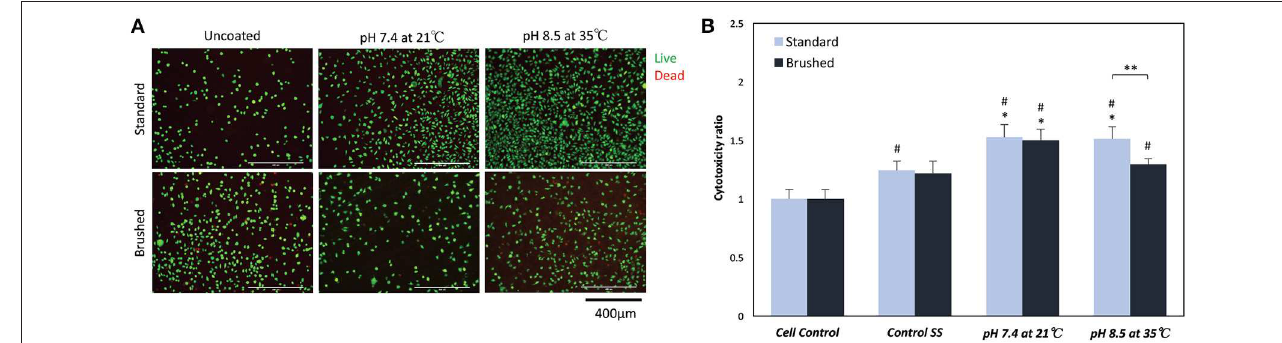
FIGURE 8 | (A) Live/Dead and (B) MTT cell biocompatibility assays. (A) Representative images on the surface of coated and uncoated 316L SS coupons. There was no significant change in the number or morphology of fibroblasts numbers on the surface of SS coupons. (B) MTT proliferation assay results showed a